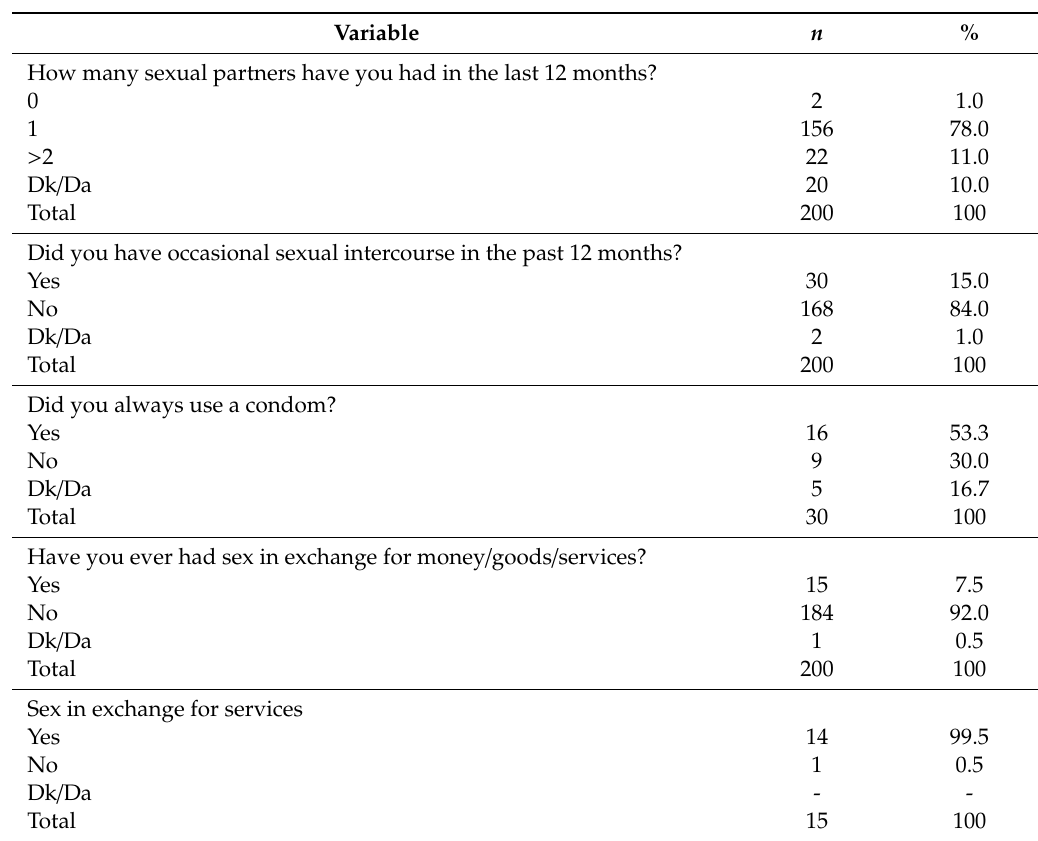
Table 5. Respondents’ sexual risk behaviors and, reported signs and symptoms of sexually transmitted infections